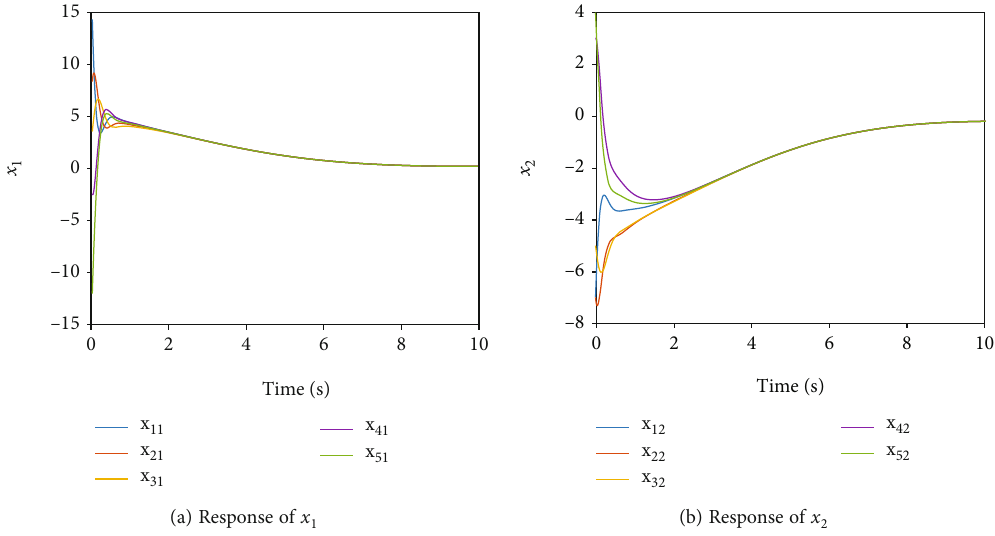
Figure 7: The response of x of proposed method.